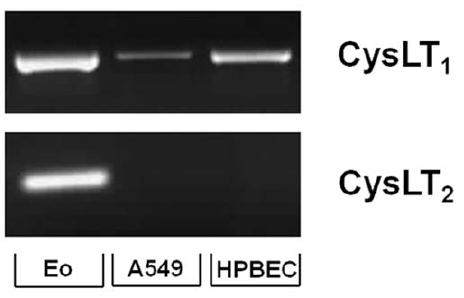
Figure 4. Expression of CysLT 1 and CysLT 2 by airway epithelial cells. Total mRNA was extracted from resting airway epithelial cells (A549), human primary bronchial epithelial cells (HPBEC) and freshly isolated human eosinophils (Eo). The expression of CysLT 1 and CysLT 2 mRNA was then analyzed by RT-PCR as described in Material and Methods . The data presented are a typical result of three independent experiments for eosinophils and airway epithelial cells, and four independent experiments for